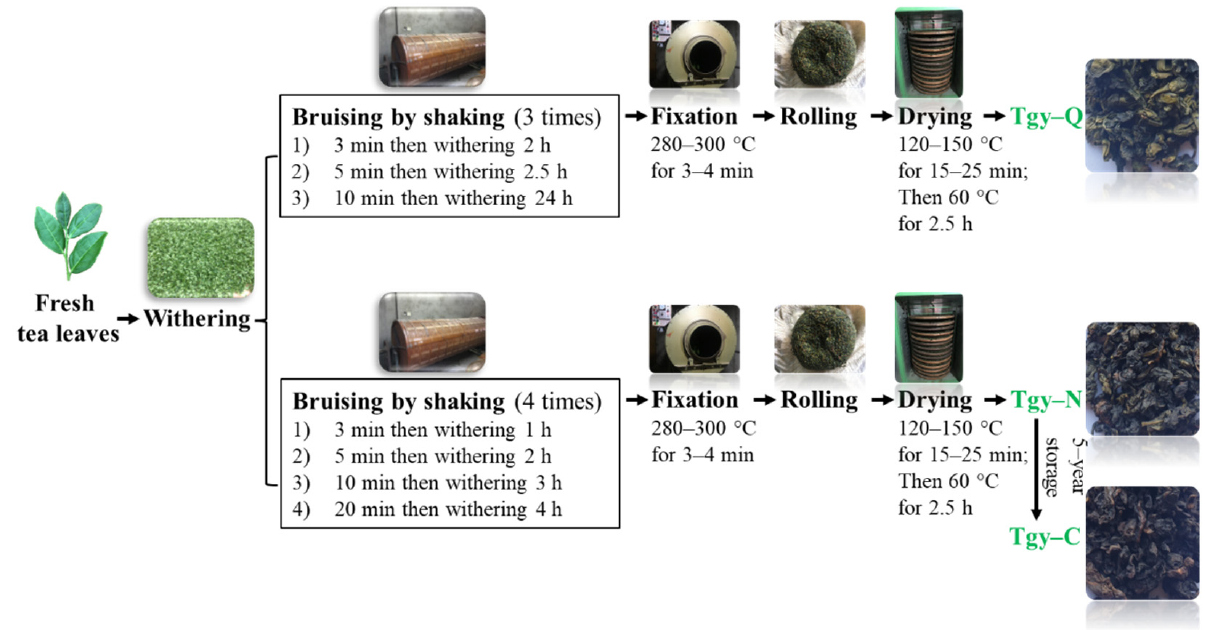
Figure 1. Manufacturing processes of making three types of Tieguanyin tea. Table 1. Major chemical constituents in the Tgy-Q, Tgy-N and Tgy-C extracts. Chemical Constituents Tgy-Q Tgy-N Tgy-C